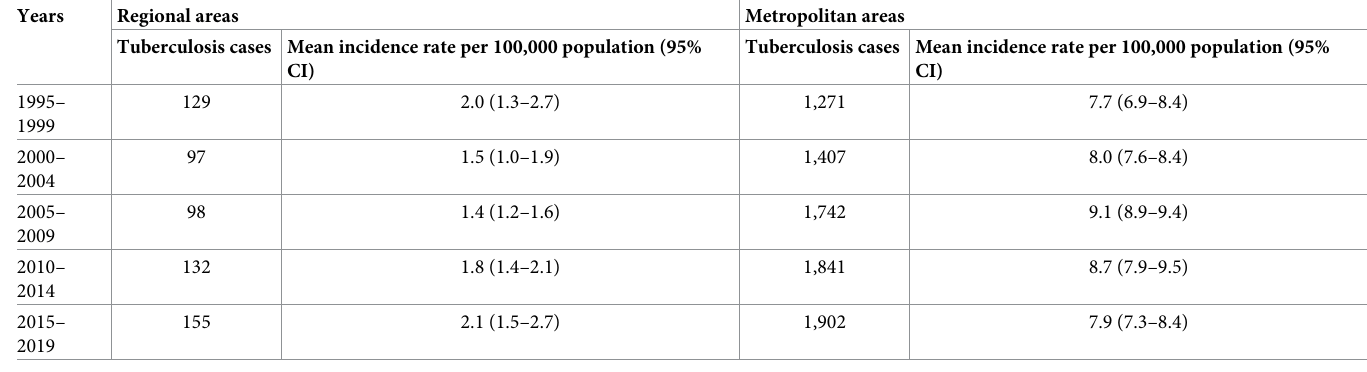
Table 2. Tuberculosis incidence rate per 100,000 population in regional Victoria and metropolitan Victoria from 1995 to 2019.